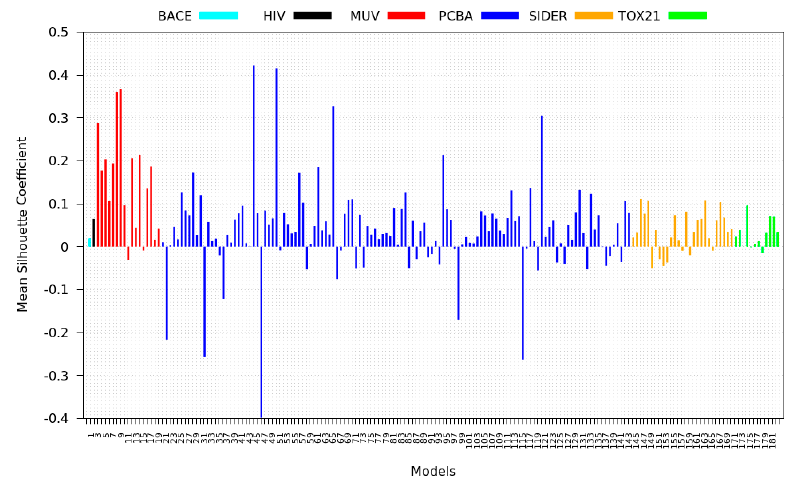
Figure A4. Detailed similarity of each source dataset to the target dataset.